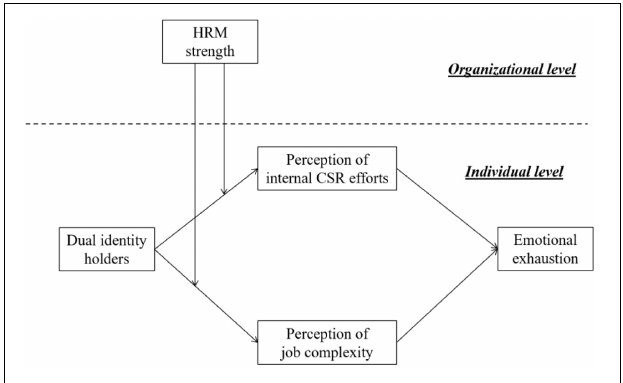
FIGURE 1 | Hypothesized